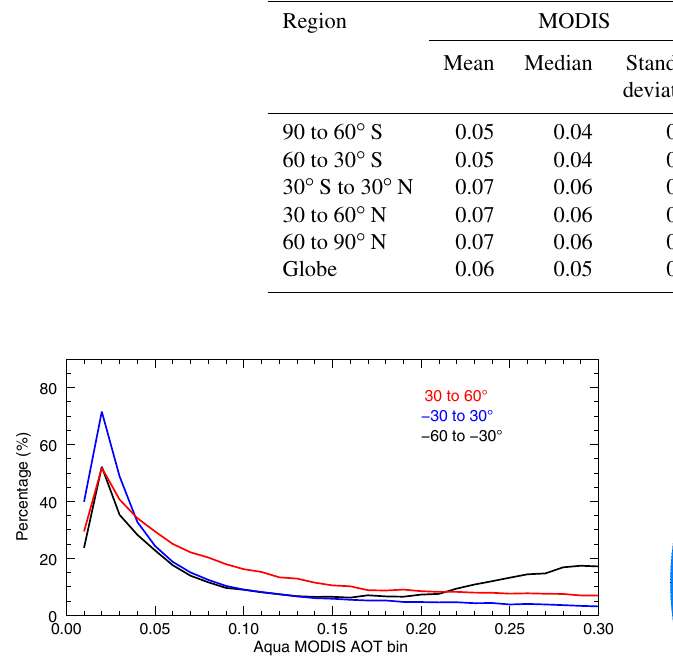
Figure 6. 2010–2011 frequency of occurrence (%) of over-ocean cloud-free CALIOP all-RFV profiles, relative to all cloud-free CALIOP profiles, as a function of collocated Aqua MODIS AOT (0.01 bins), for 30 to 60 ◦ N (in red), − 30 to 30 ◦ N (in blue), and − 60 to − 30 ◦ N (in black).